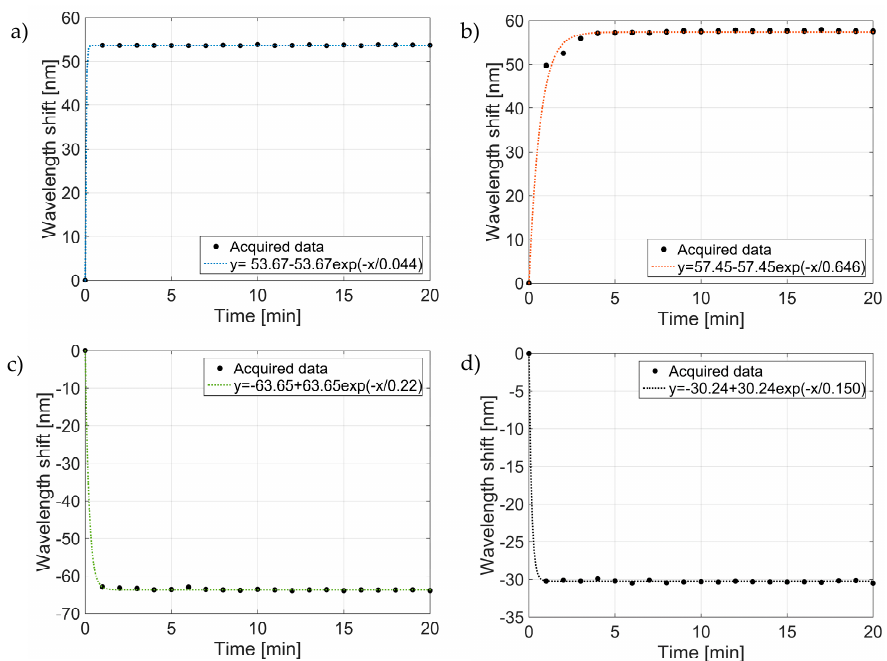
Figure 3. Resonant wavelength shifts measured during the fabrication steps of the previous deposition procedure. ( a ) Dipping step, ( b ) first drying step, ( c ) rinsing step, ( d ) second drying